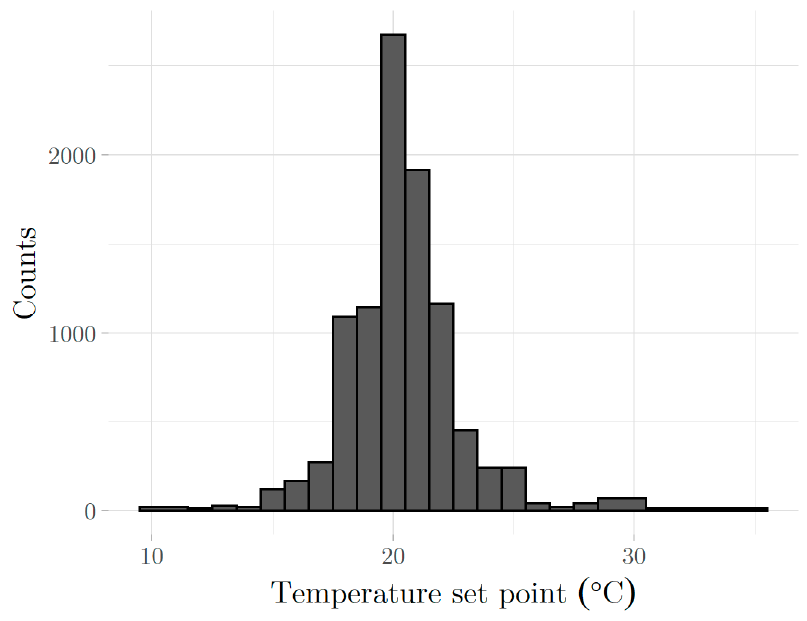
Figure 18. Self-reported winter afternoon temperature set points in °C for those who could control the temperature of their heating (question A5). Outliers are excluded and bars with fewer than 10 participants have been